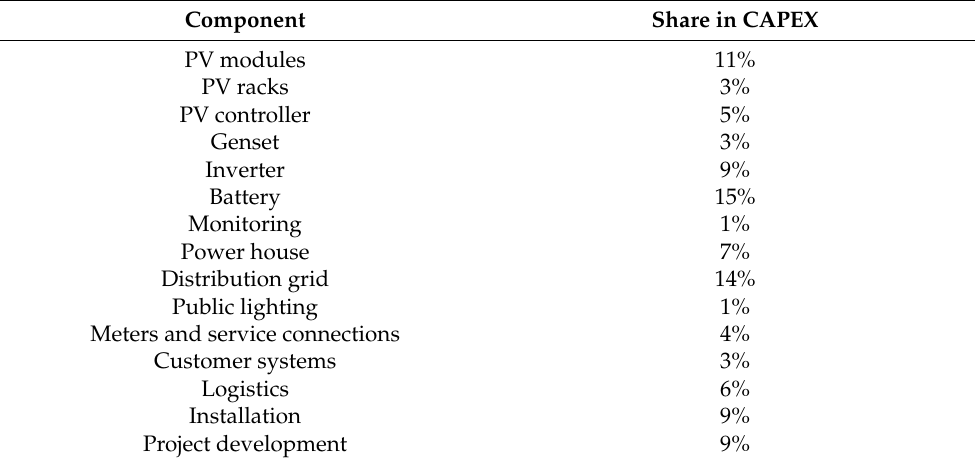
Table 3. Share of mini grid CAPEX by component based on the World Bank survey. Reproduced with permission from